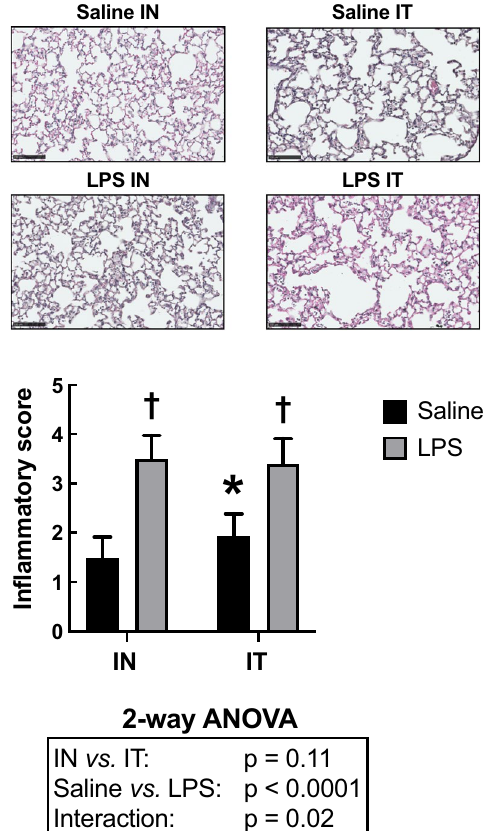
Figure 3. Cellular inflammatory infiltrates into the parenchymal tissue. The upper panels are representative lung sections derived from mice treated with either saline (top) or LPS (bottom) through either the intranasal (IN) or the intratracheal (IT) route. The bar graph below depicts the mean inflammatory score in each group. Scale bars are 100 µm. The results of the two-way ANOVA are shown at the bottom of the graph. *Indicates statistically significant from the IN-exposed group treated with saline. †Indicates statistically significant from the group treated with saline exposed through the same route. n = 18 per group and the data shown are means ±